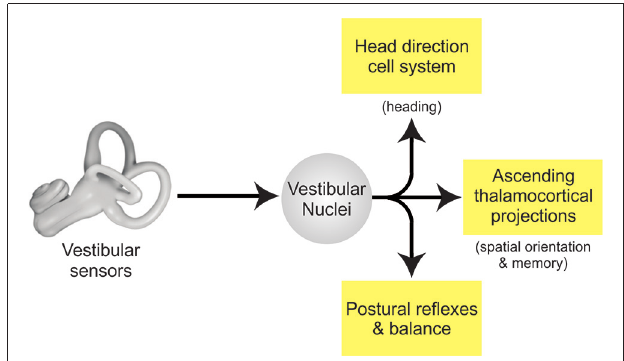
FIGURE 2 | Vestibular pathways for spatial memory. Vestibular signals from the labyrinth of the inner ear are transferred to the VN via the vestibular afferents of the VIII nerve. In turn, the VN projects to other brain areas to: (i) control posture and balance, (ii) produce estimates of spatial orientation, and (iii) encode heading